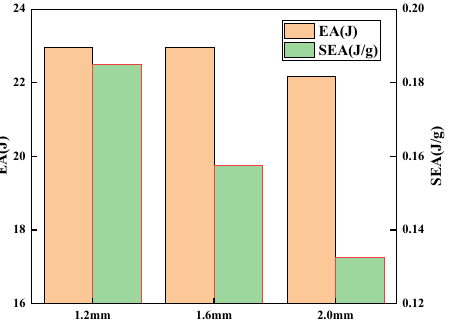
Figure 11. EA and SEA of sandwich panels with different face sheet thicknesses.